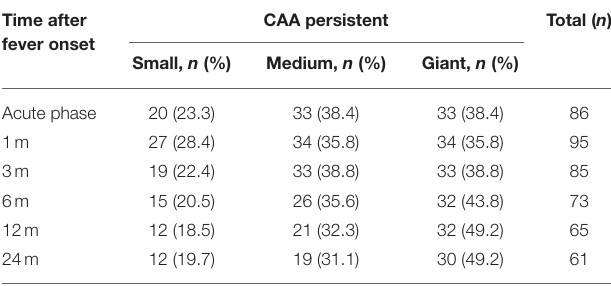
Time after fever onset